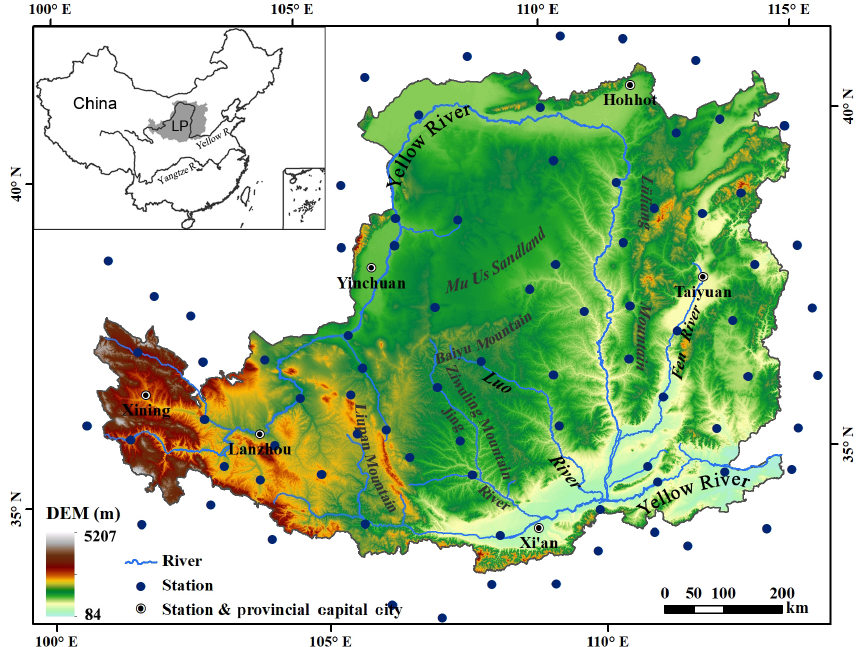
Figure 2. Location of the Loess Plateau in the middle reaches of the Yellow River, China (inset), and the distribution of the meteorological stations in and around the